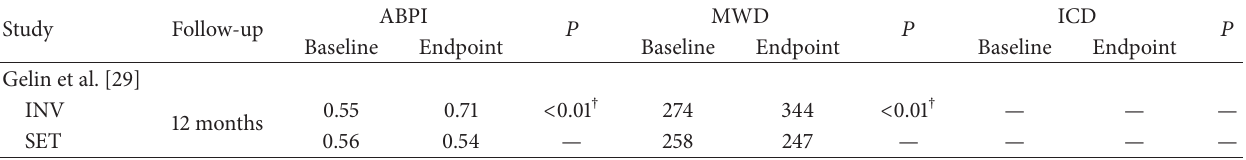
Table 5: Invasive (EVR or surgery) management versus supervised